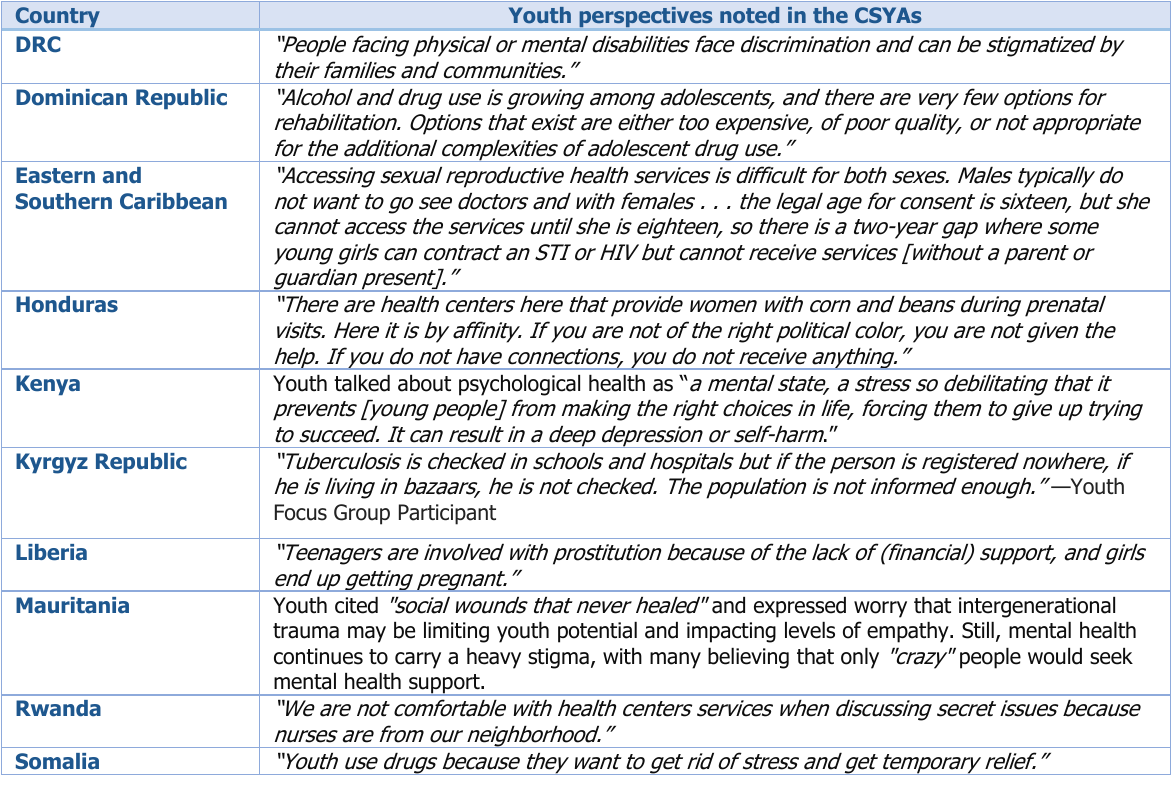
Table 8. Youth Perspectives on Health